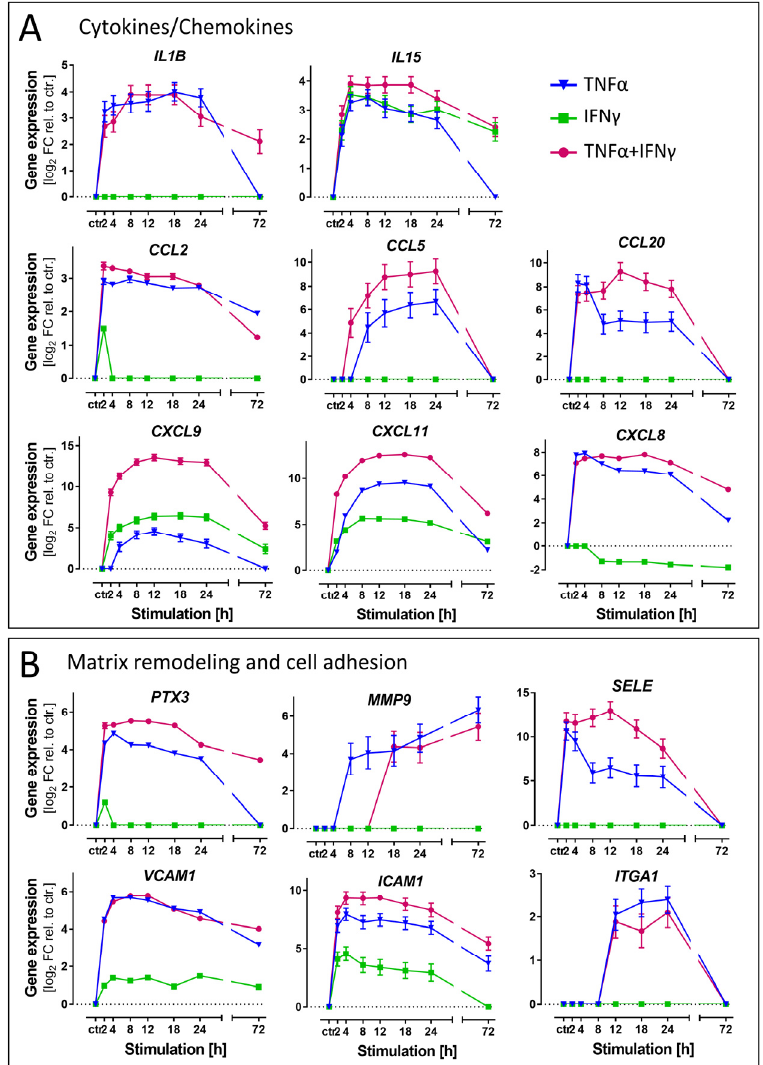
Figure 5. Differential regulation of exemplary genes coding for inflammation markers. Gene expression data were obtained from ACs as detailed in Figure 4. ( A ) Levels of mRNA for exemplary cytokines/chemokines. ( B ) Levels of mRNA for exemplary proteins involved in matrix remodeling and cell adhesion. All data are means ± SD from four samples (two samples each from 2 independent differentiations). Ctr.: unstimulated control ACs.